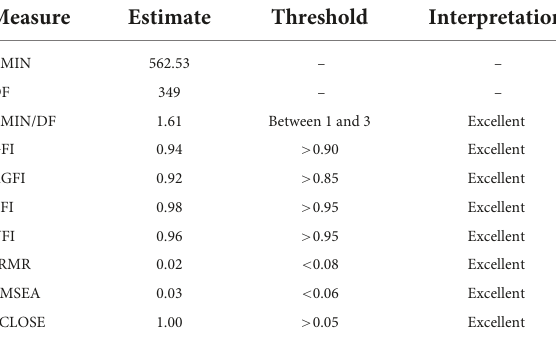
TABLE 2 Model fit